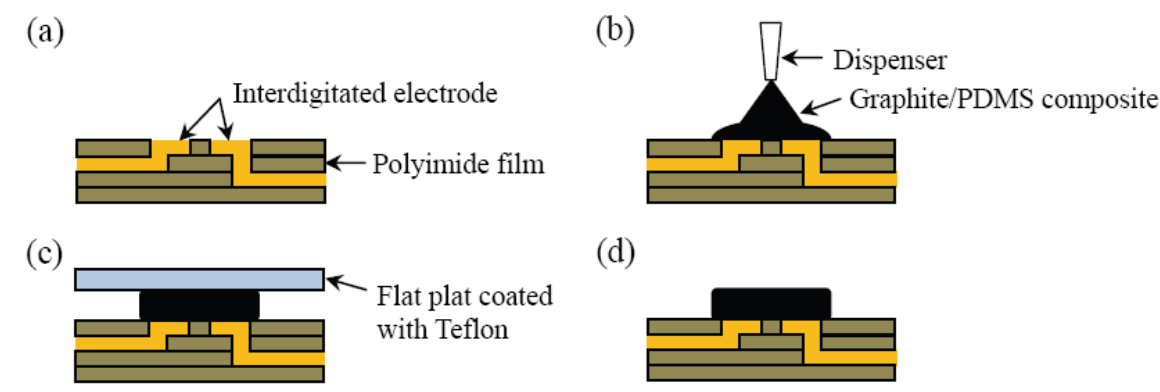
Figure 4. Process flow for fabricating the temperature sensor array. (a) Flexible printed circuit. (b) Applying graphite/PDMS composite on the interdigitated electrode. (c) Applying a flat plate coated with Teflon to flatten the composite. (d) Curing the composite and then removing the